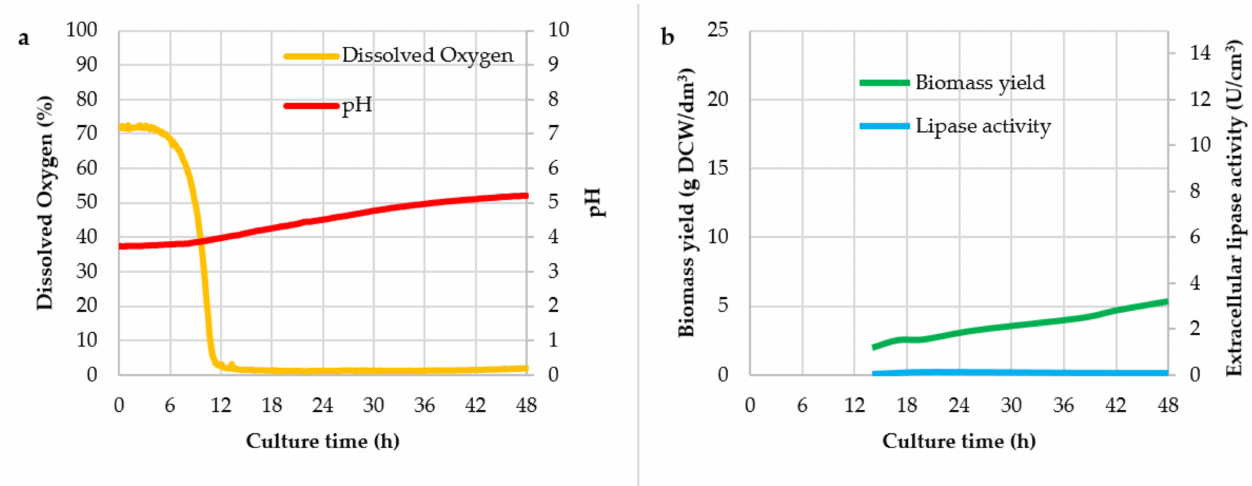
Figure 1. Kinetics of dissolved oxygen and pH ( a ) and biomass yield and extracellular lipase activity ( b ) of the yeast strain Y. lipolytica KKP 379 in the culture with an agitation speed of 200 rpm and air flow of 0.375 dm 3 /(dm 3 ×